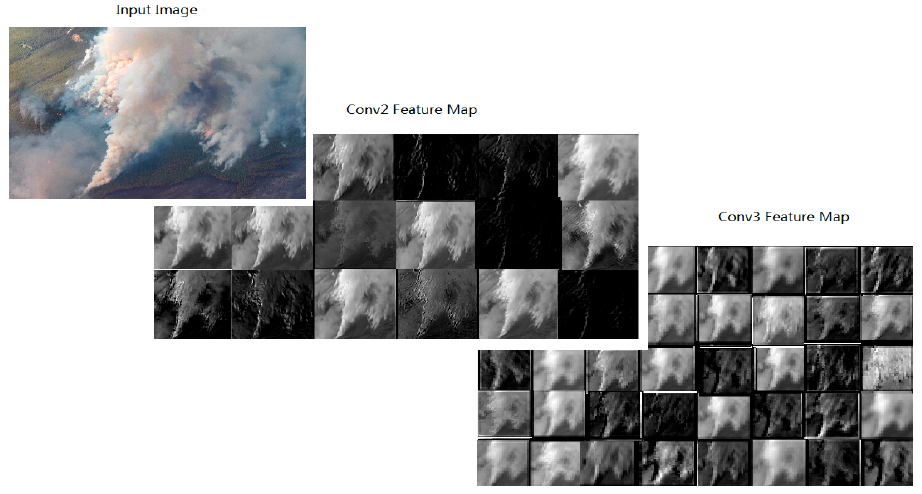
Figure 9. Visualization of feature maps after layer Conv2 and layer Conv3 in Fire_Net.